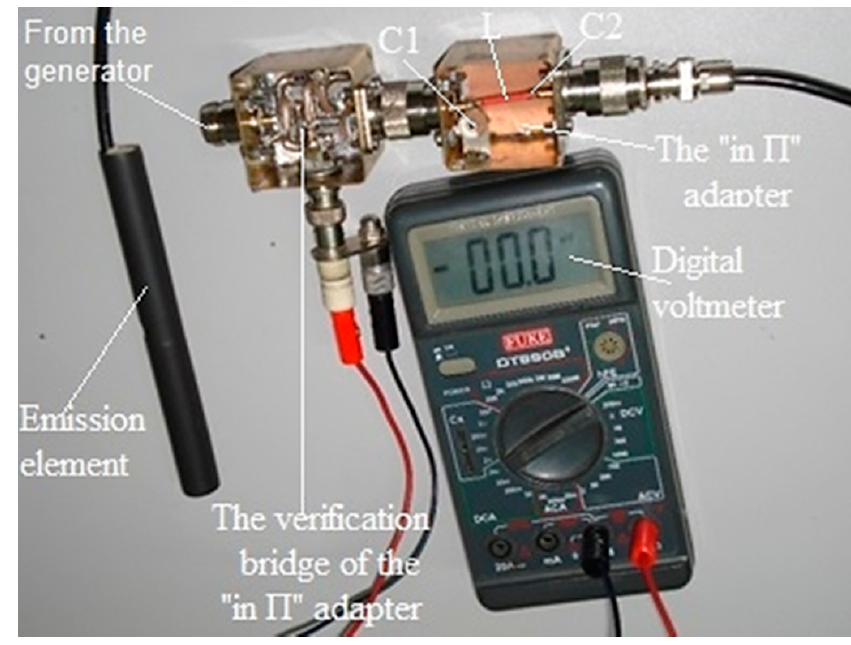
Figure 6. Practical mounting diagram for adjusting the impedance adapter “in Π ”. After the verifications carried out, practical measurements were made inside the mine. Measurements were made with the emission element and reception electromagnetic sensor placed in the air (Figure 7) and with them placed in saline environment for the vertical plane: the emission element introduced in saline environment (Figure 8), reception electromagnetic sensor introduced in saline environment (Figure 9) and the measurement result for 187.5 MHz frequency (Figure